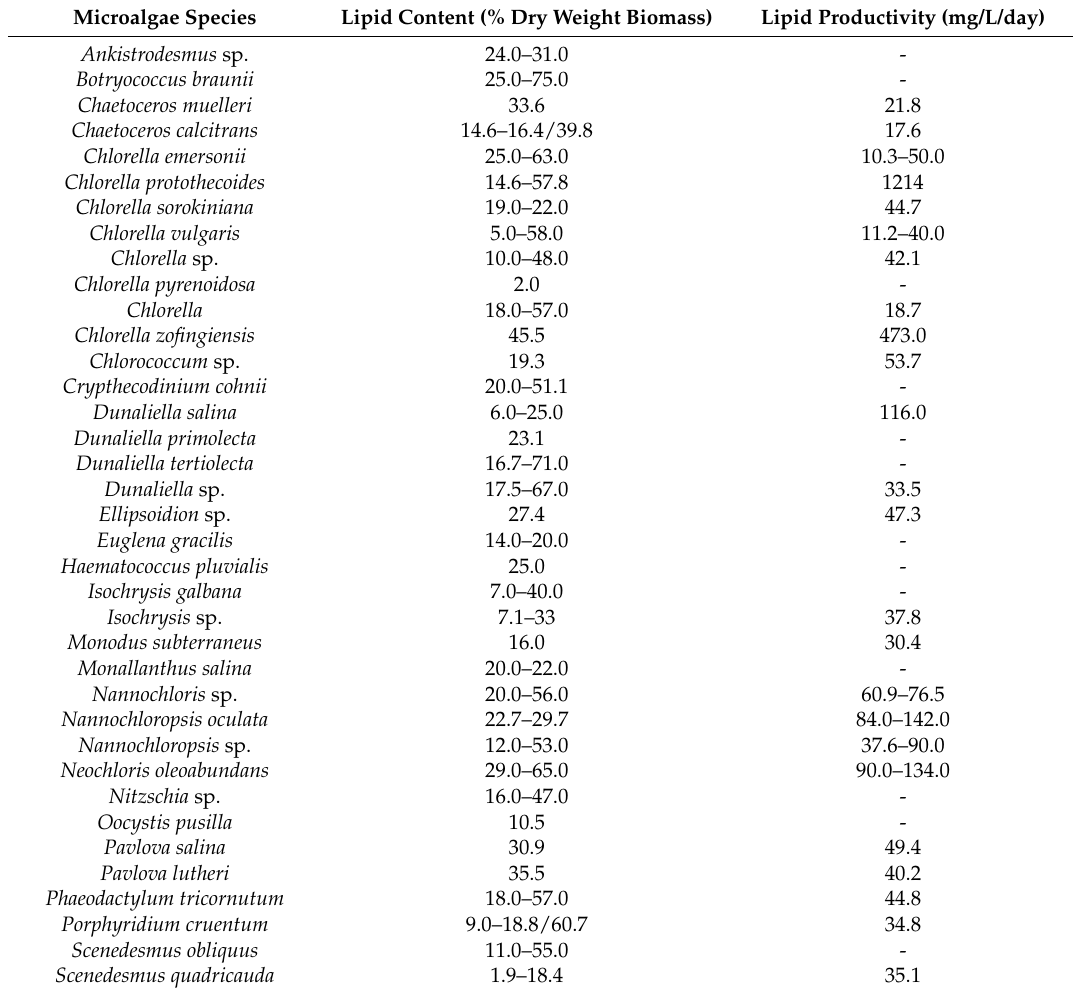
Table 2. Lipid content from different microalgae species. Modified from [14] with added information from